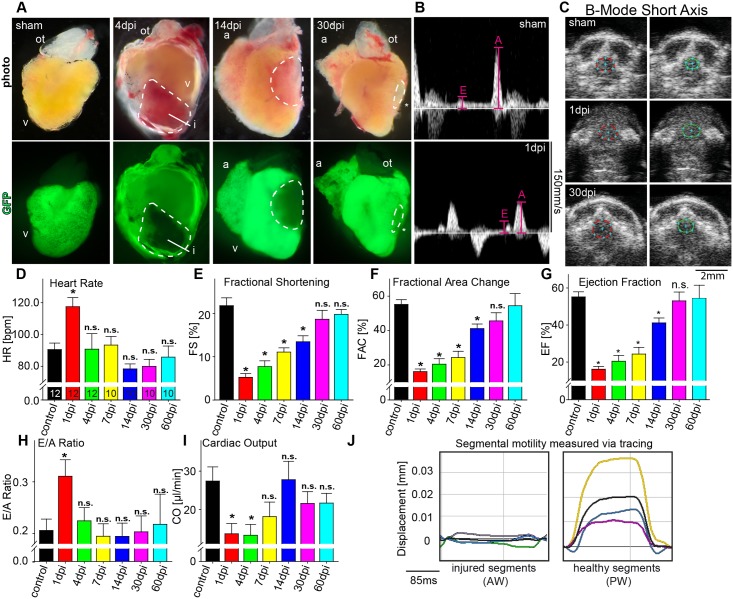
Longitudinal echocardiographic evaluation of cardiac function after cryoinjury.(A) Lateral brightfield (top) and fluorescent (bottom) images of hearts derived from sham operated transgenic zebrafish [Tg(myl7:GFP)
f1] and after cryoinjury at depicted time points. Dashed lines indicate injured myocardial area (i). (B) PWD recordings from sham (top) and cryoinjured zebrafish at 1dpi (bottom) demonstrating decreased A-wave and increased E-wave amplitudes indicative for diastolic dysfunction. (C) Representative SAX images from sham (upper row) and cryoinjured zebrafish at 1dpi (middle row) and at 30dpi (lower row) with end-diastolic dimensions illustrated in red and end-systolic dimensions in green. (D-I) Quantification of changes in (D) heart rate (HR), (E) fractional shortening (FS), (F) fractional area change (FAC), (G) ejection fraction (EF), (H) E/A ratio and (I) cardiac output (CO) at baseline and at indicated time points during regeneration after myocardial injury. Small number in (D) indicates number of animals analyzed (J) Speckle-tracking analysis of segmental displacement shows akinesia of injured (green, pink and light blue line) as compared to the non-injured segments (yellow, purple and dark blue line). The average curve of all segments is illustrated in black. For color coding of different segments see Fig 2B. Values are expressed as means ± SEM; a, atrium; i, injured area; ot, outflow tract; v, ventricle; AW, anterior wall; PW, posterior wall; *, p<0.05; unpaired student’s t-test and ANOVA with post hoc comparisons by Bonferroni’s multiple comparison test.